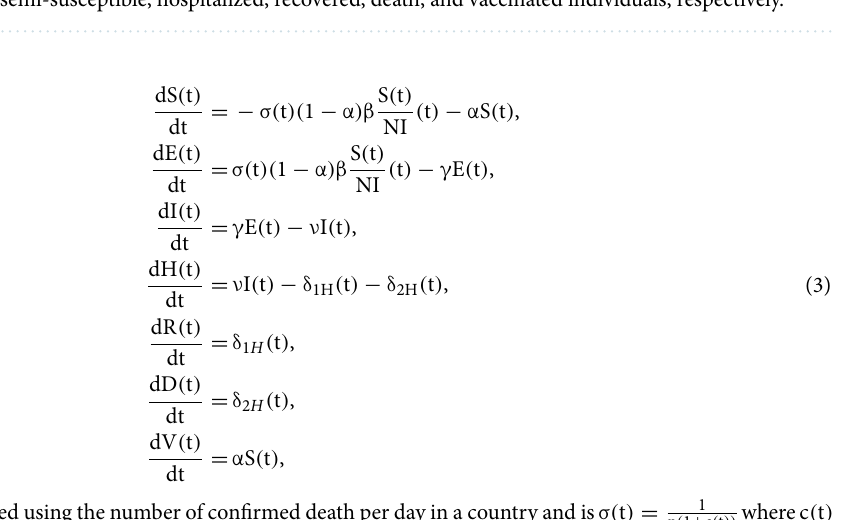
Figure 2. SMEIHRDV model. SMEIHRDV model that S, M, E, I, H, R, D and V are the number of susceptible, exposed, infected, semi-susceptible, hospitalized, recovered, death, and vaccinated individuals,